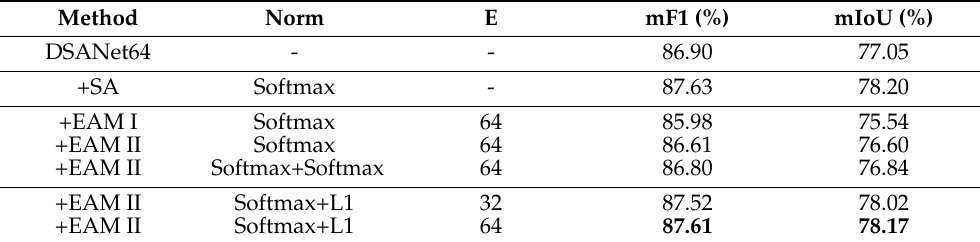
Table 3. Comparison Among Combinations of Different EAMs and Configurations on the Potsdam Dataset.